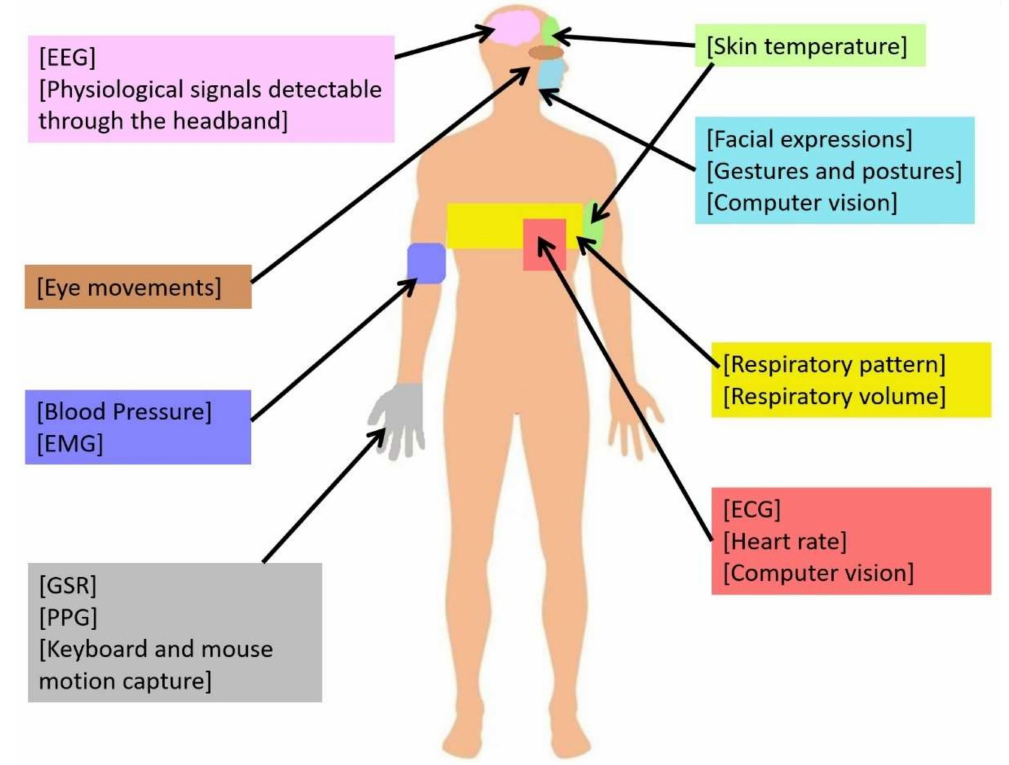
Figure 1. Physiological Variables for Engagement Detection and Associated Body